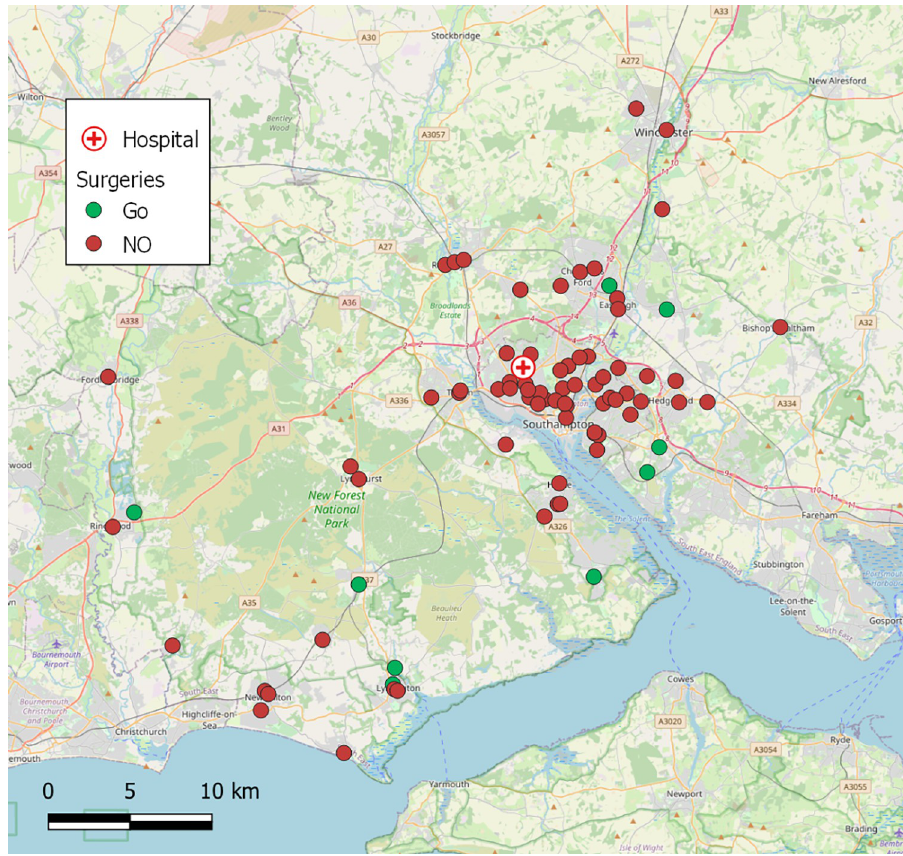
Fig 8. GP Surgeries in the Southampton area coloured by GO/NO-GO Status. GO = suitable for a 5m fixed- wingspan craft to land without excessive ground overflight risk (mean risk of a fatality on the ground due to a UAV crashing along its flightpath = 1 × 10 − 7 or lower). Airspace restrictions are not considered. Base map and data from OpenStreetMap and OpenStreetMap Foundation.